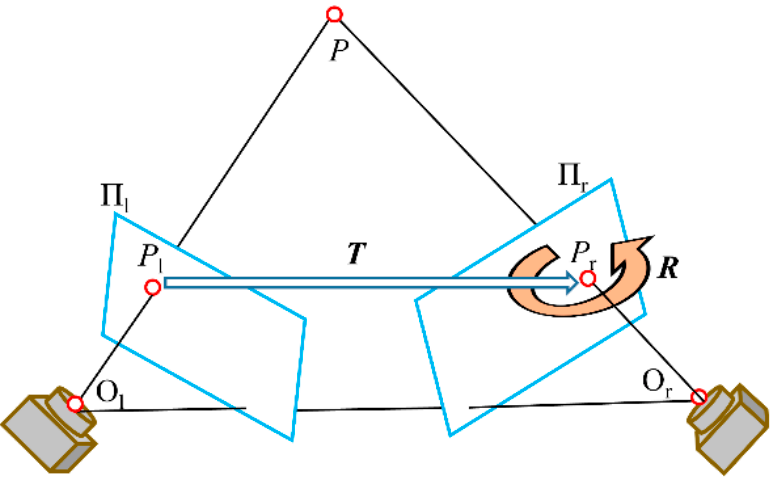
Figure 4. Principle of stereo calibration for binocular camera. Combining Equations (1) and (2)